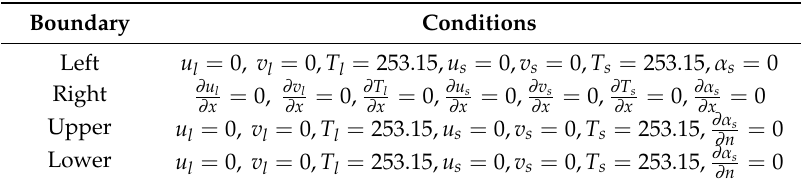
Table 3. The settings of the boundary conditions (Case 1,